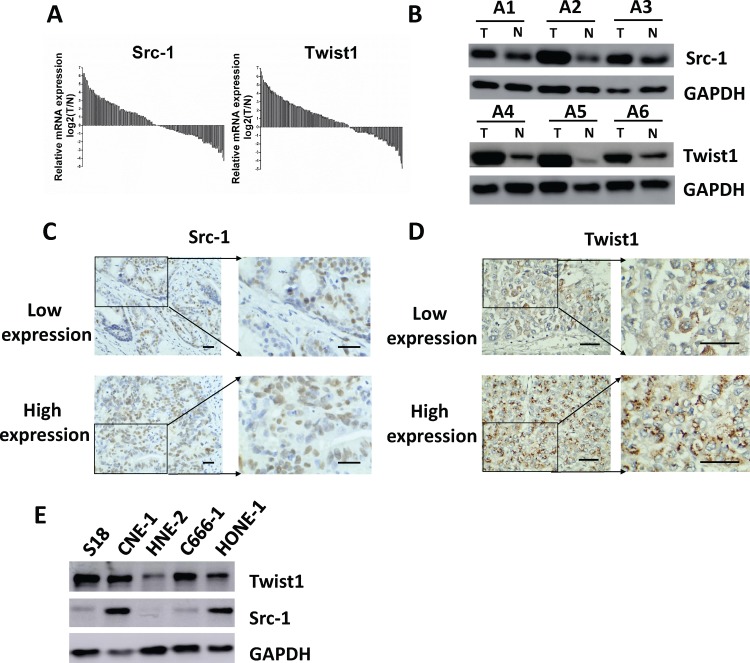
Src-1 and Twist1 is aberrantly up-regulated in nasopharyngeal carcinoma tissues.(A) the mRNA expression of Src-1 and Twist1 in tumor samples and adjacent normal tissues of the 134 NPC patients was evaluated by qRT-PCR, then relative mRNA expression Log2 (T/N) was calculated. (B) Src-1 or Twist1 expression in tumor samples (T) and paired normal tissues (N) of selected NPC patients was evaluated by western blot. (C, D) Representative images of IHC staining and statistical results for low and high expression of Src-1 or Twist1 in tumor tissues of NPC patients. Scale bars = 50μm. (E) Protein expression of Src-1 and Twist-1 in a panel of nasopharyngeal carcinoma cell lines.